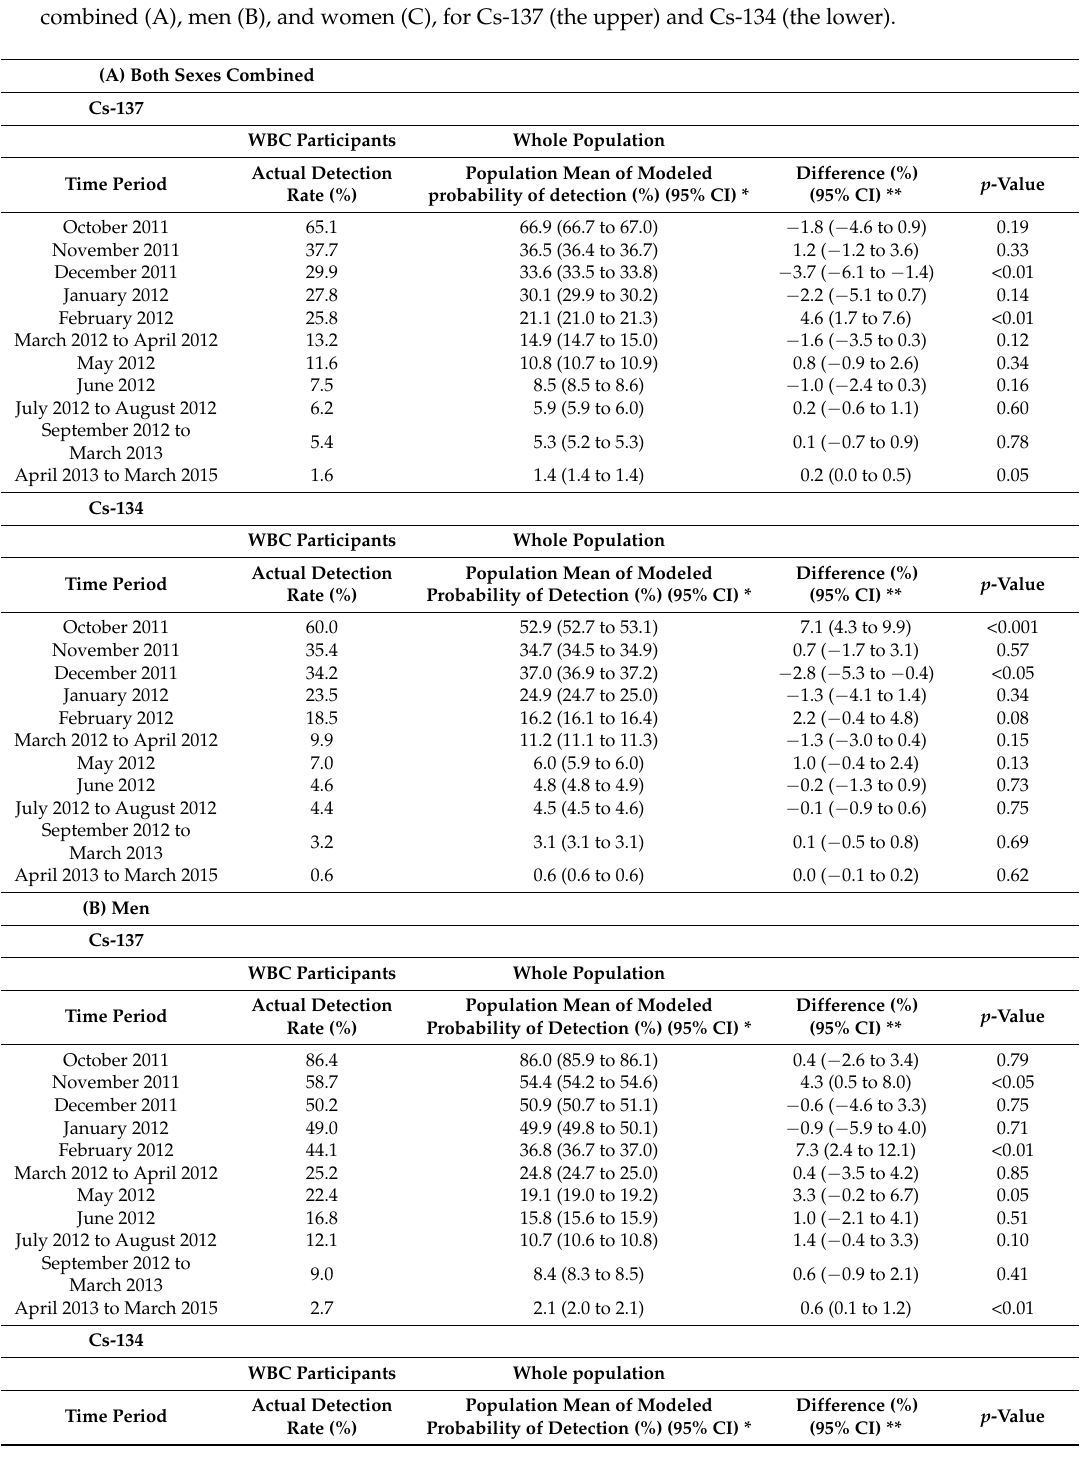
Table 2. Comparison between population means of modeled estimates of probability of Cs detection and actual detection rate in whole body counter (WBC) monitoring participants, for both sexes combined (A), men (B), and women (C), for Cs-137 (the upper) and Cs-134 (the